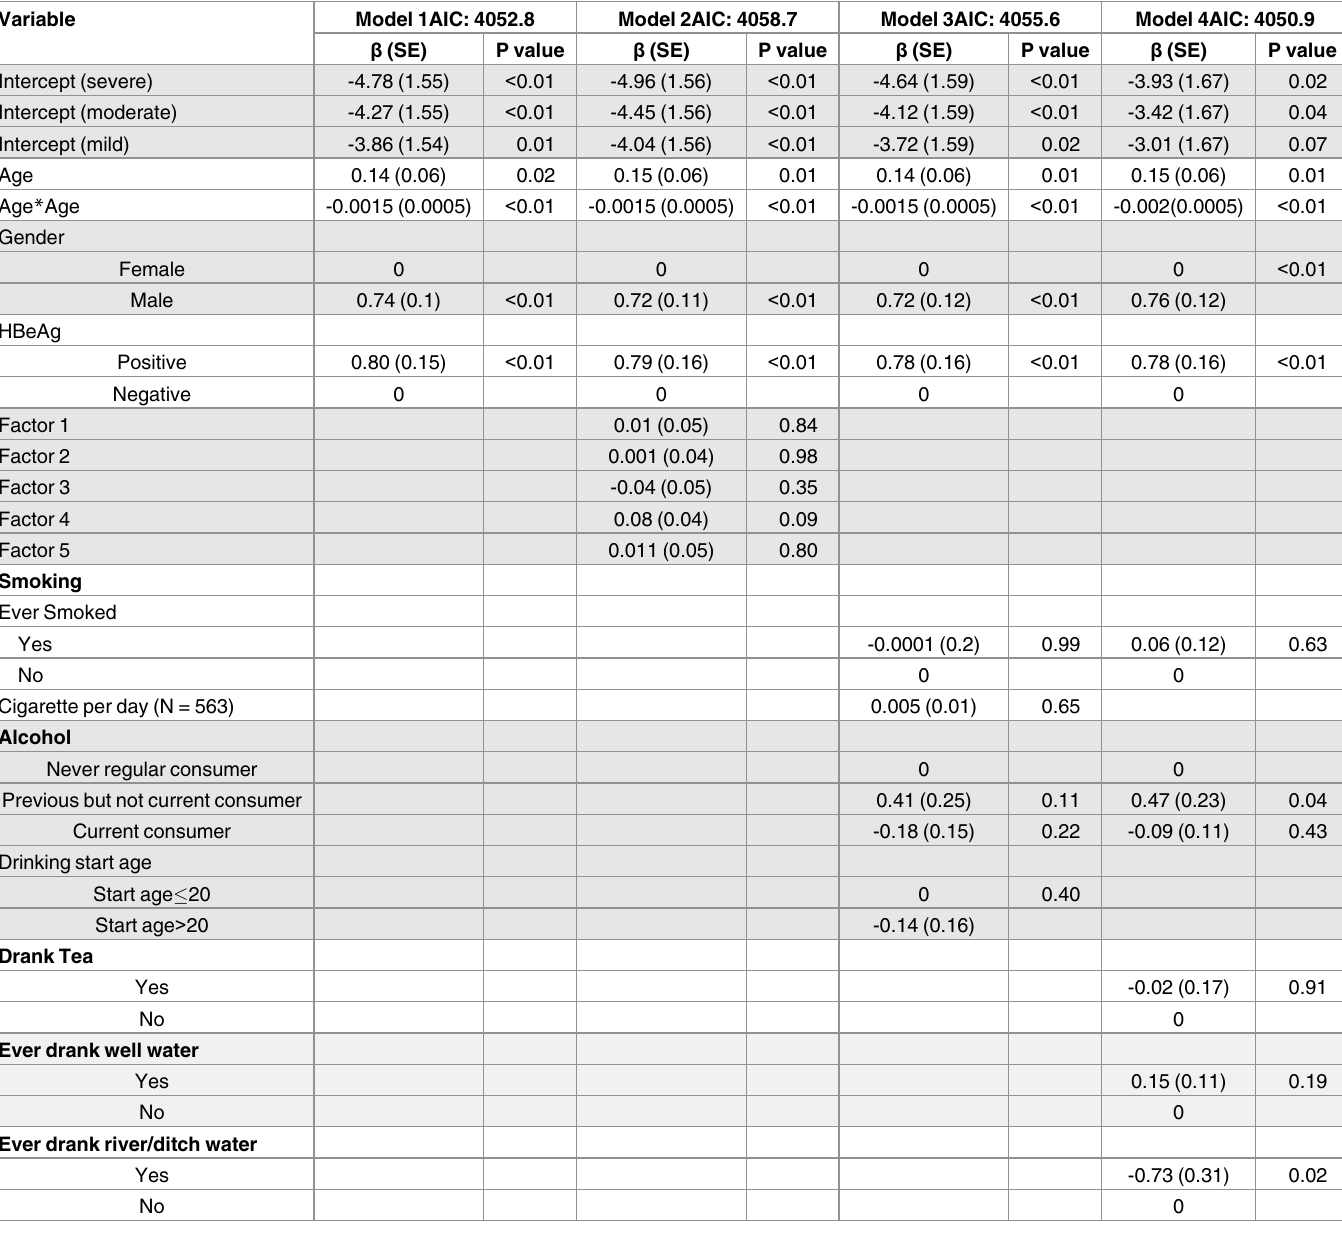
Table 3. Cumulative logit regression model of liver disease severityand risk